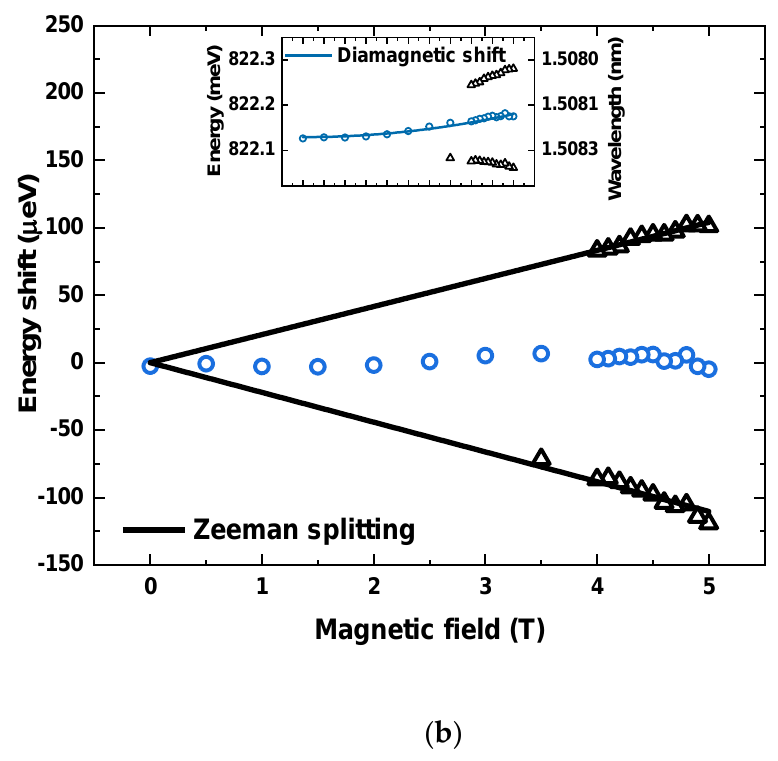
Figure 4. Voigt configuration PL spectra. ( a ) PL spectra for magnetic fields from 0 to 4 T with 0.5 T step, and from 4 to 5 T with 0.1 T step ( b ) Energy of optical transitions versus magnetic field, after subtraction of the diamagnetic shift (open black triangles). Black lines are fits to Zeeman energy. Inset shows as measured energy of optical transitions versus magnetic field, without subtraction of diamagnetic shift (blue line).